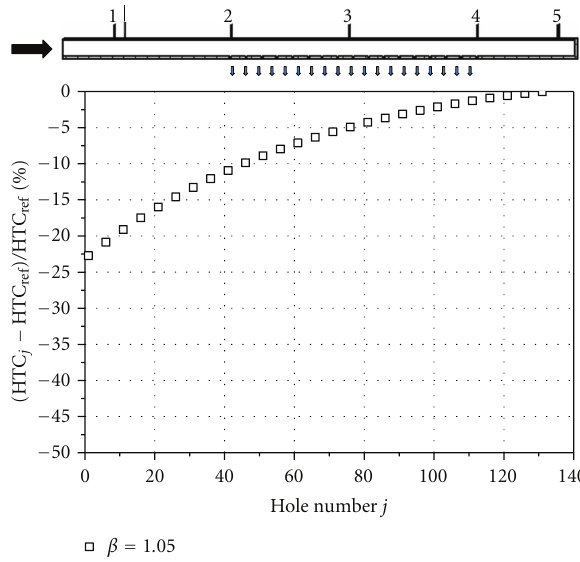
Figure 11: Mean heat transfer coe ffi cient distribution for Geom 2 ( A r = 1 . 08) β = 1 .